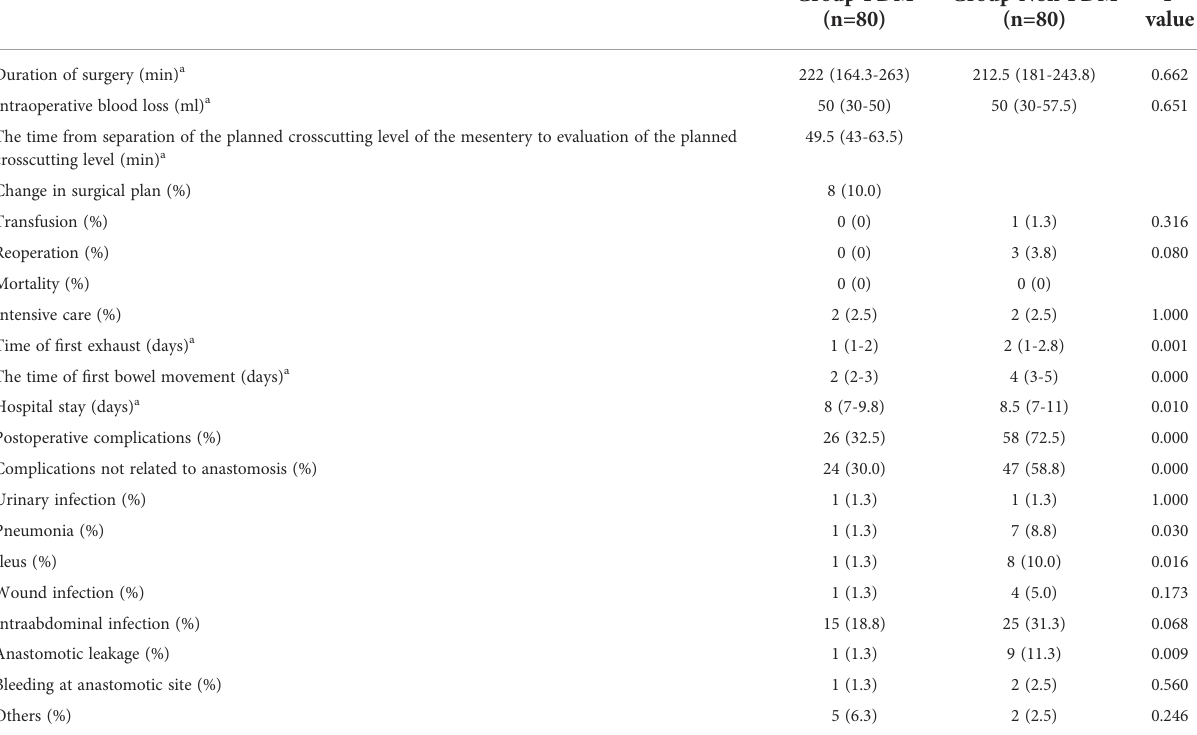
TABLE 5 Operative Outcomes and postoperative complication after propensity score matching.